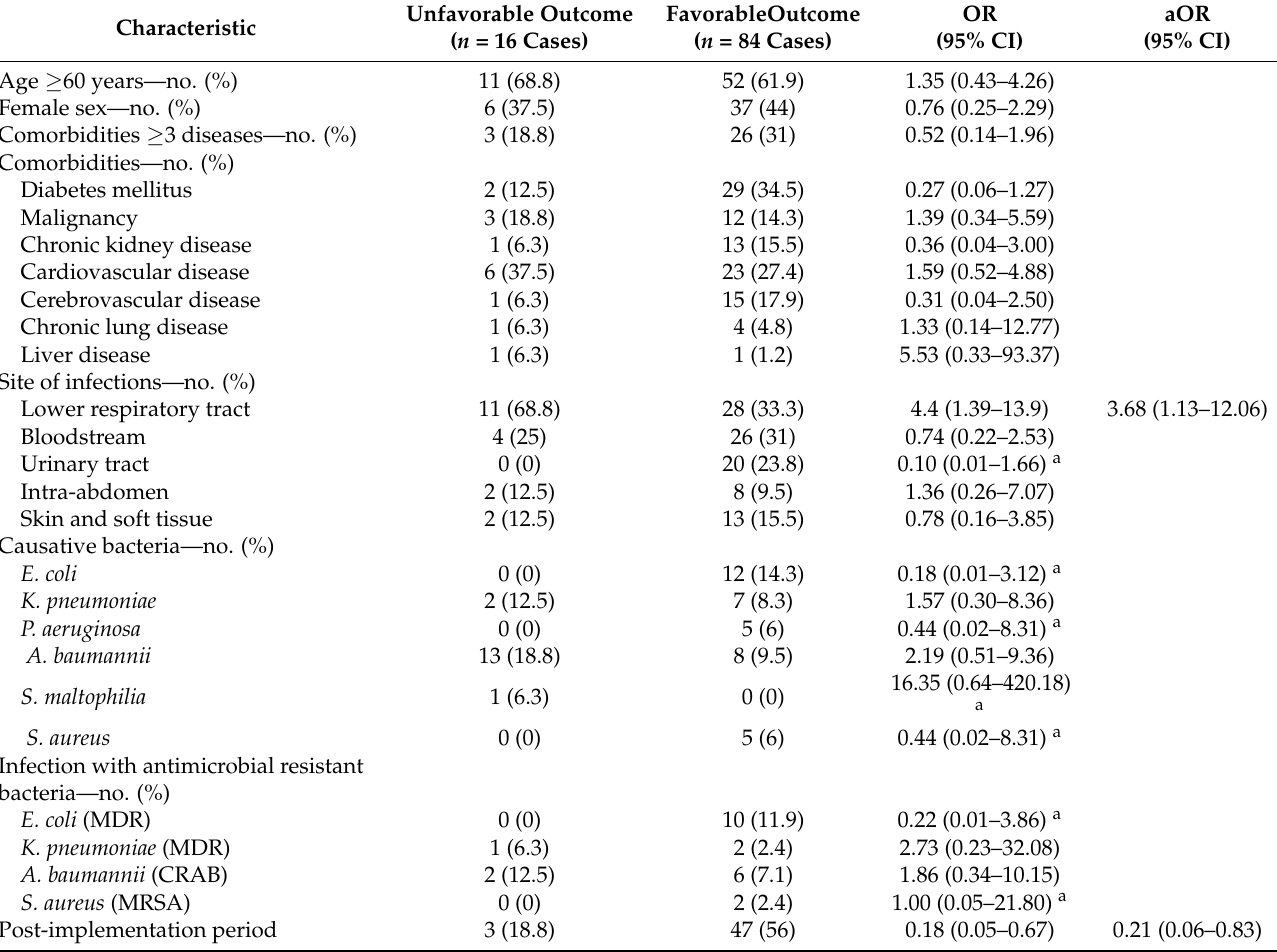
Table 3. Factors predicting unfavorable outcome among patients with CohPAT using univariate analysis and logistic regression